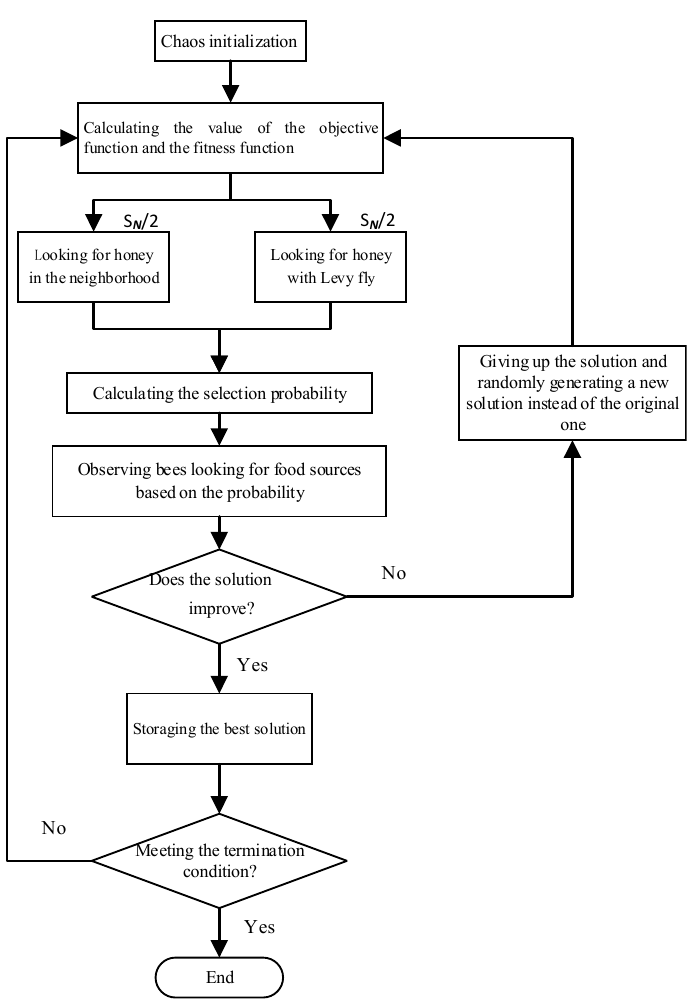
Figure 1. Principle of the Improved Artificial Bee Colony Algorithm.